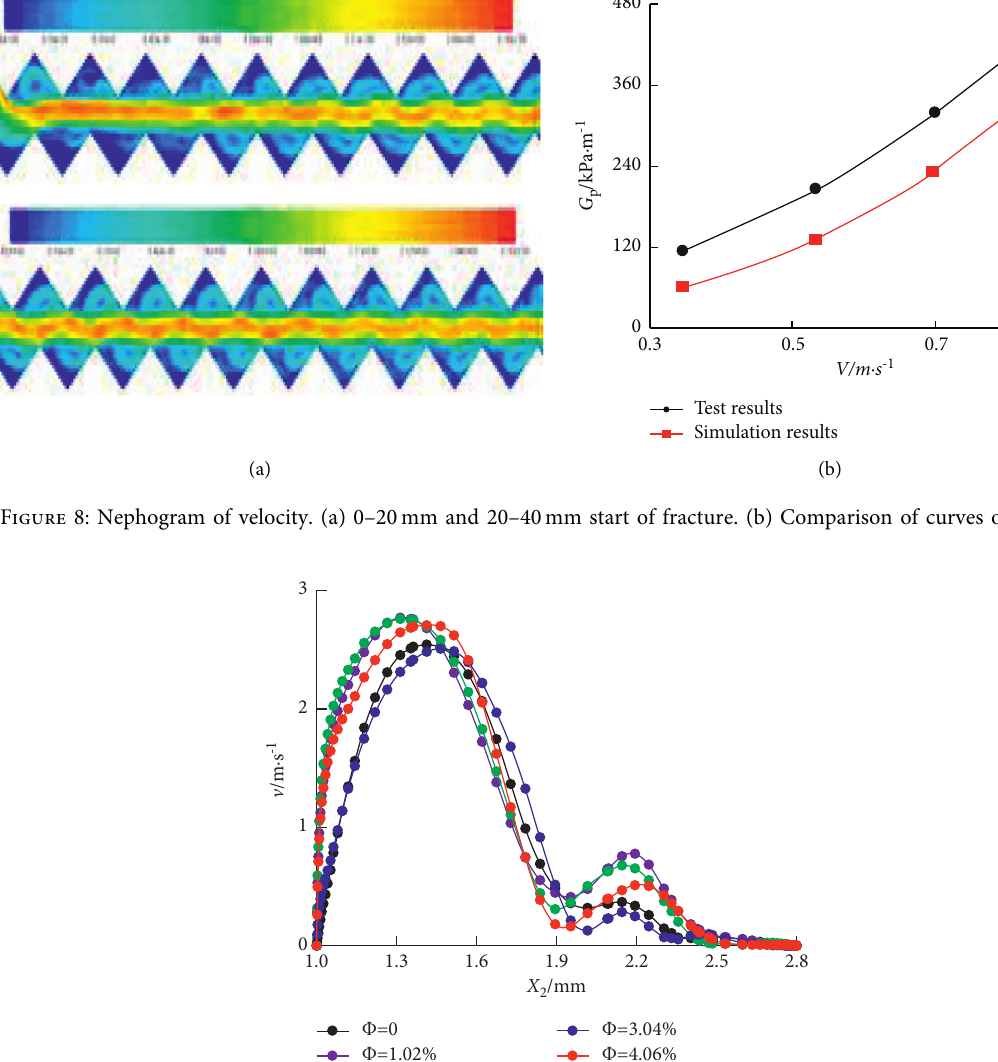
Figure 9: Uniform velocity distribution of continuous phase fluid on cross section of rough